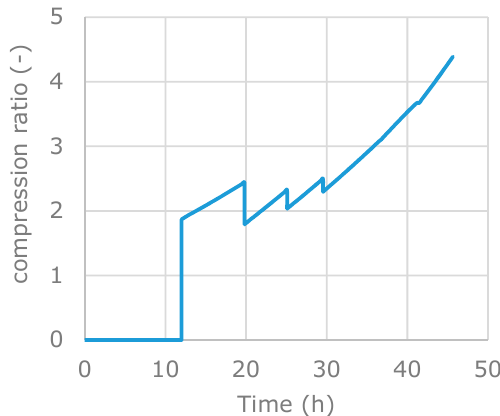
Appl. Sci. 2020 , 10 , x FOR PEER REVIEW